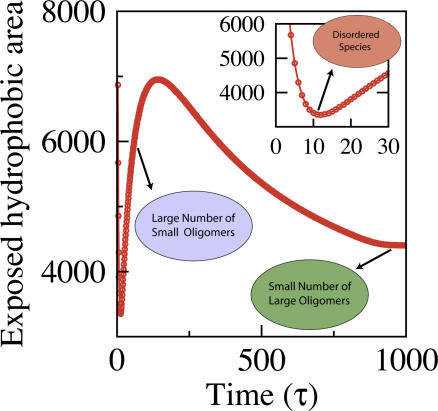
Time Dependence of the Total Exposed Hydrophobic Area in the Oligomeric EnsembleTime dependence of the solvent-exposed hydrophobic surface area (S) for the Aβ16–22 fragment (see Methods). Two competing processes contribute to the evolution of the species. At early times, S increases due to the reorganisation process of the initially formed oligomers driven by the formation of hydrogen bonds. By contrast, S decreases as the typical size of the oligomers grows and the surface-to-volume ratio becomes smaller and the consequent decrease in the number of oligomers present in the system. In the inset we show an expansion of the early time points representing the effect of the initial hydrophobic coalescence of the monomers into disordered oligomers.